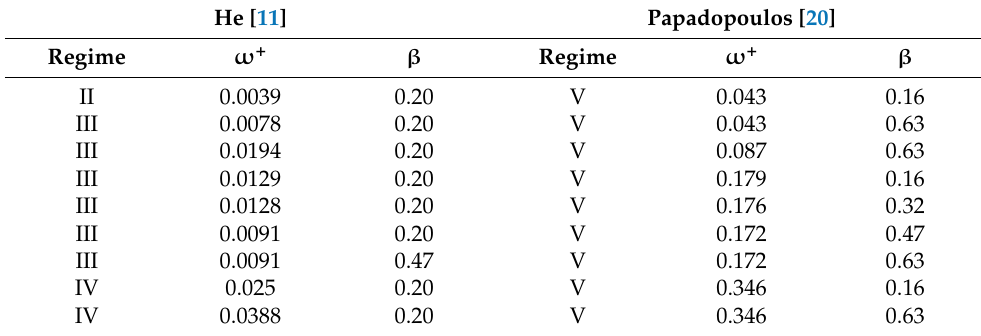
Table 2. Measurements of velocity profiles in pulsating flow.